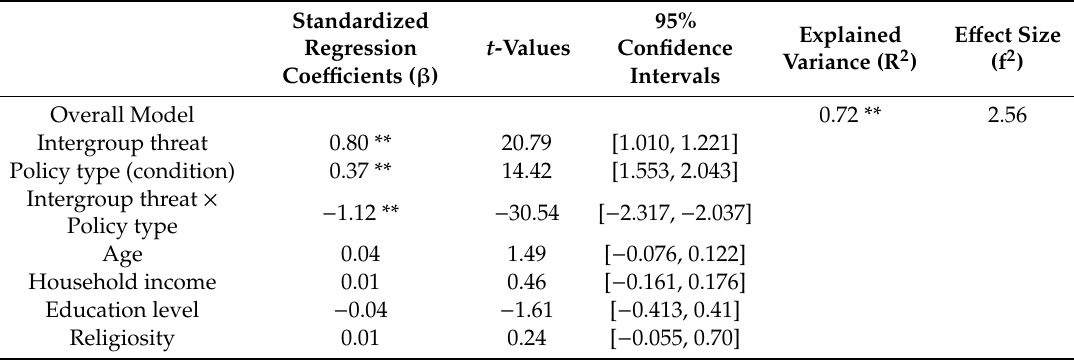
Table 3. Regression analysis predicting admissions policy